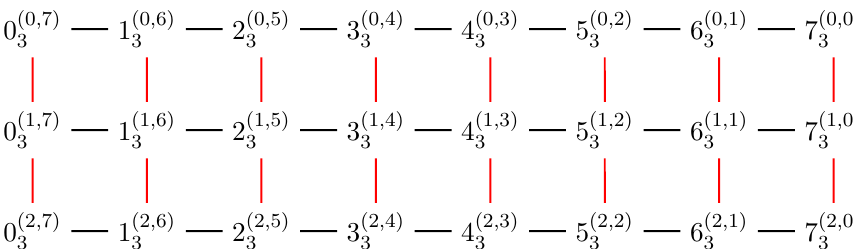
Figure 2 . Branes with g (cid:0) 3 with all T-dualities that act between them. The horizontal s